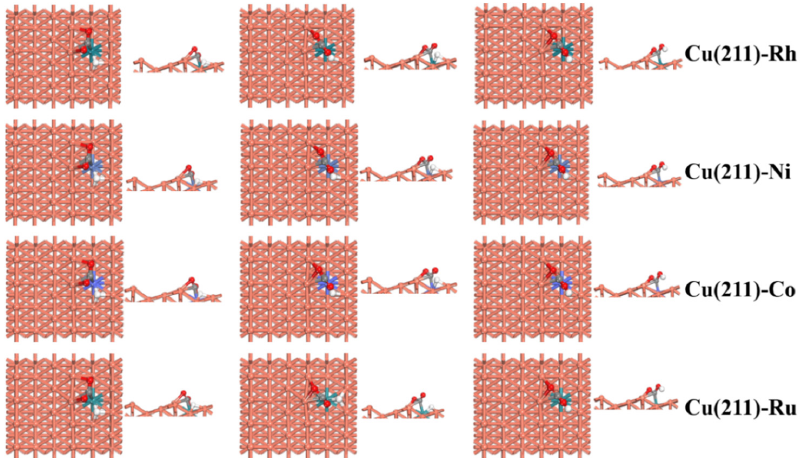
Figure 3. Top and side views of the initial state (IS), transition state (TS), and final state (FS) for CO 2 activation via COOH intermediate on the pure and transition-metal-doped Cu(211)-M (M = Rh, Ni, Co, and Ru) surfaces.